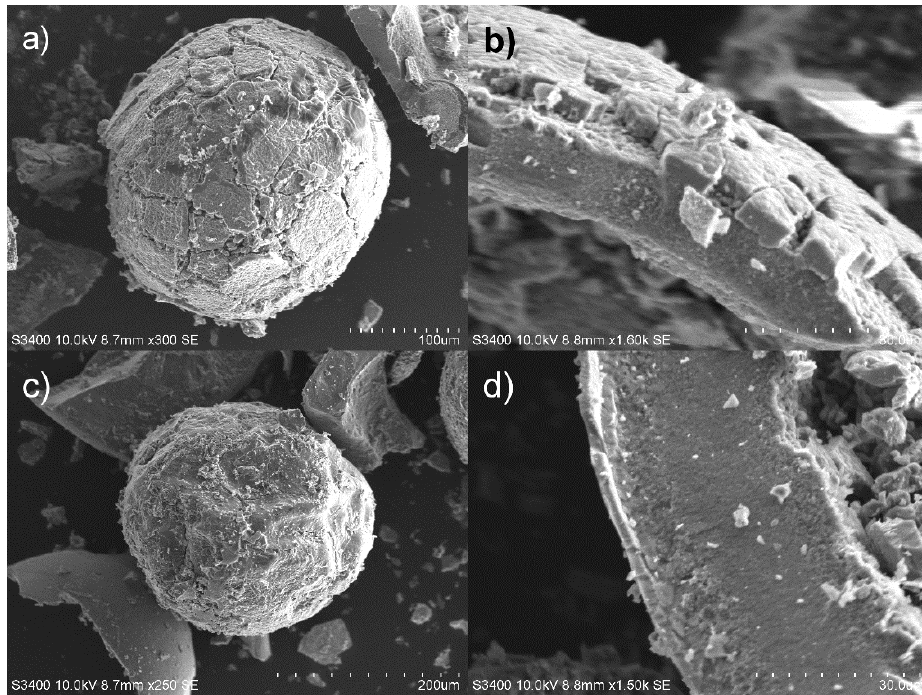
Figure 1. SEM images of hybrid materials: ( a ) CWM1#MnO 2 bead’s outer surface, ( b ) structure of CWM1#MnO 2 surface layer, ( c ) CWM3#MnO 2 bead’s outer surface, ( d ) structure of CWM3#MnO 2 surface layer.